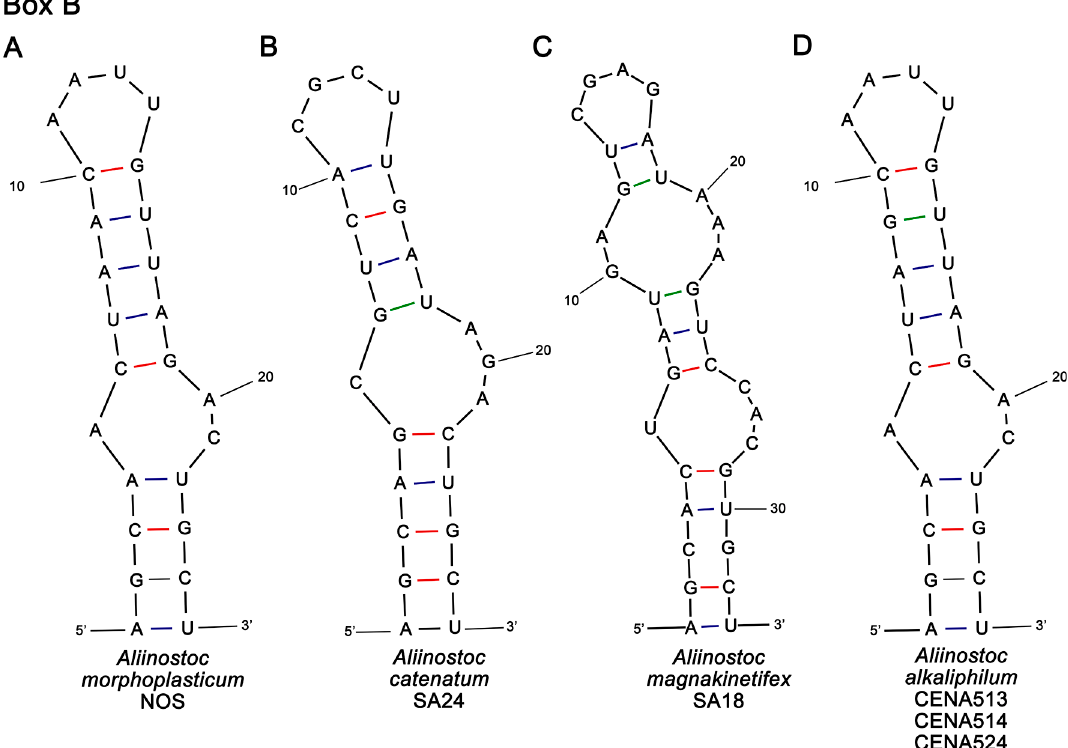
Figure 5. Hypothetical secondary structures of conserved box B helices of the 16S-23S ITS regions of Aliinostoc species identified in operons lacking tRNA genes. ( A ) Aliinostoc morphoplasticum NOS (KY403996). ( B ) A. catenatum SA24 (MK503792). ( C ) A. magnakinetifex SA18 (MK503791). ( D ) A. al- kaliphilum CENA513 T , CENA514 and CENA524 (OK042917, OK042919 and OK042921, respectively).